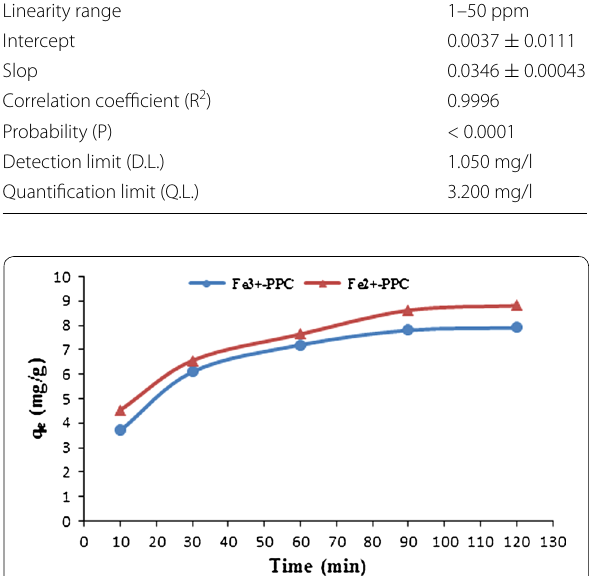
Fig. 3 The effect of contact time on adsorption capacity. The change of adsorption capacity in removal of Pb 2 + vs contact time for Fe 2 + -PPC is depicted in red and for Fe 3 + -PPC is depicted in blue